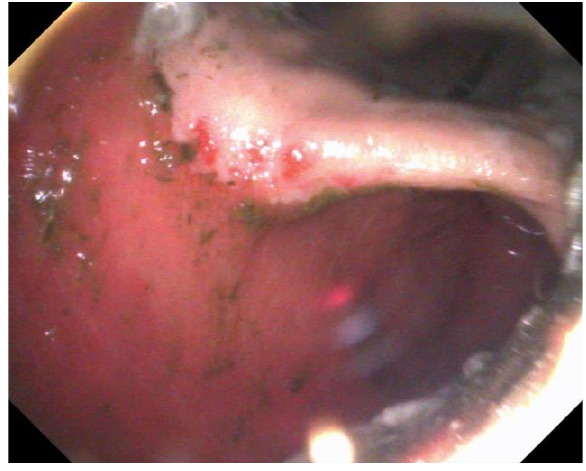
Figure 2. Multifocal, hyperemic lesions of the lesser curvature; grade 2/4 ESGD lesions.